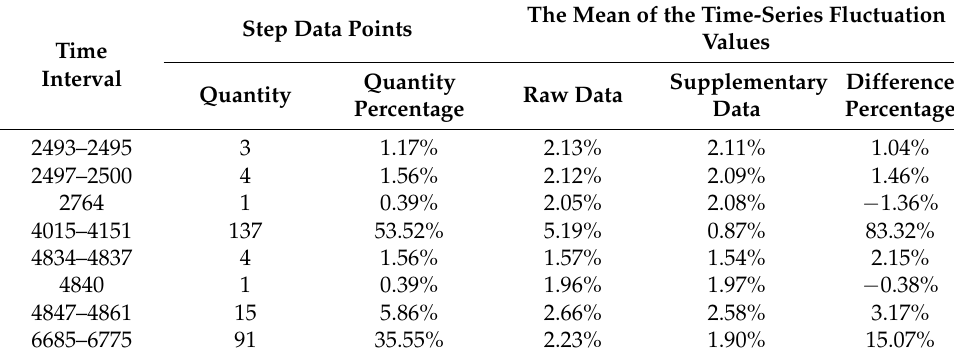
Table 3. Step data points and associated calculation results for the flow of supply water.